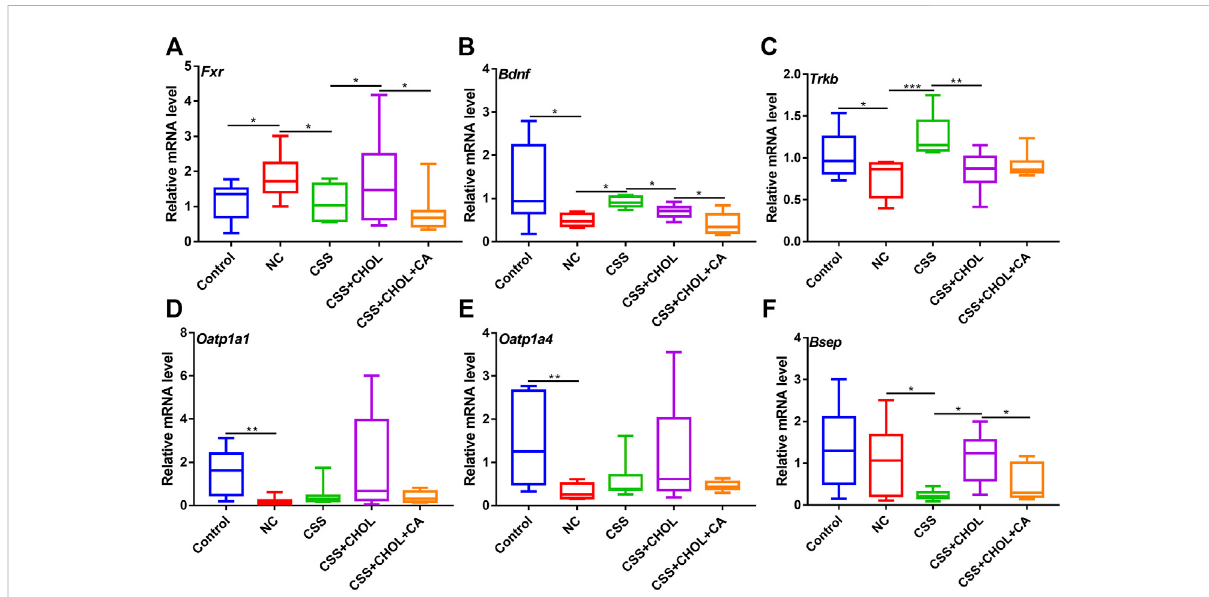
FIGURE 5 CSS alters expression of genes associated with BA transport and neurotrophic signaling in the hippocampus of CUMS mice. Hippocampi were collected from control mice as well as mice exposed to CUMS and treated with CSS or CSS + CHOL (with or without CA). Transcript levels of